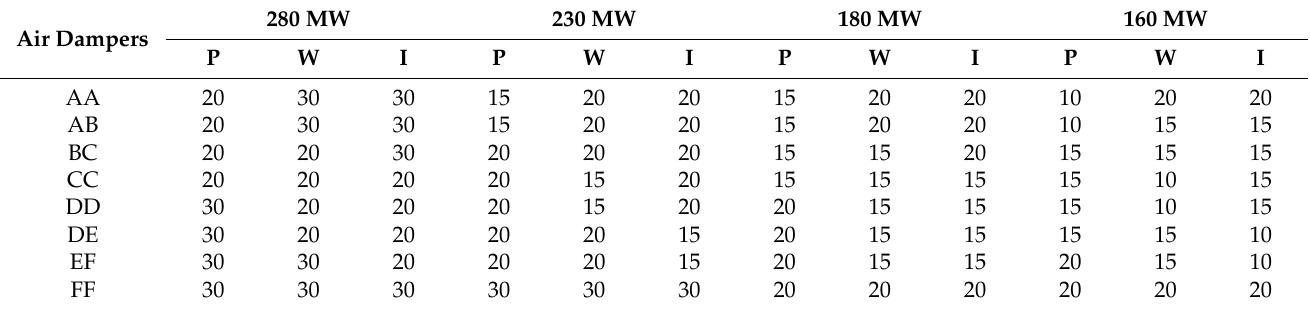
Table 8. Combustion damper opening under different air distribution methods